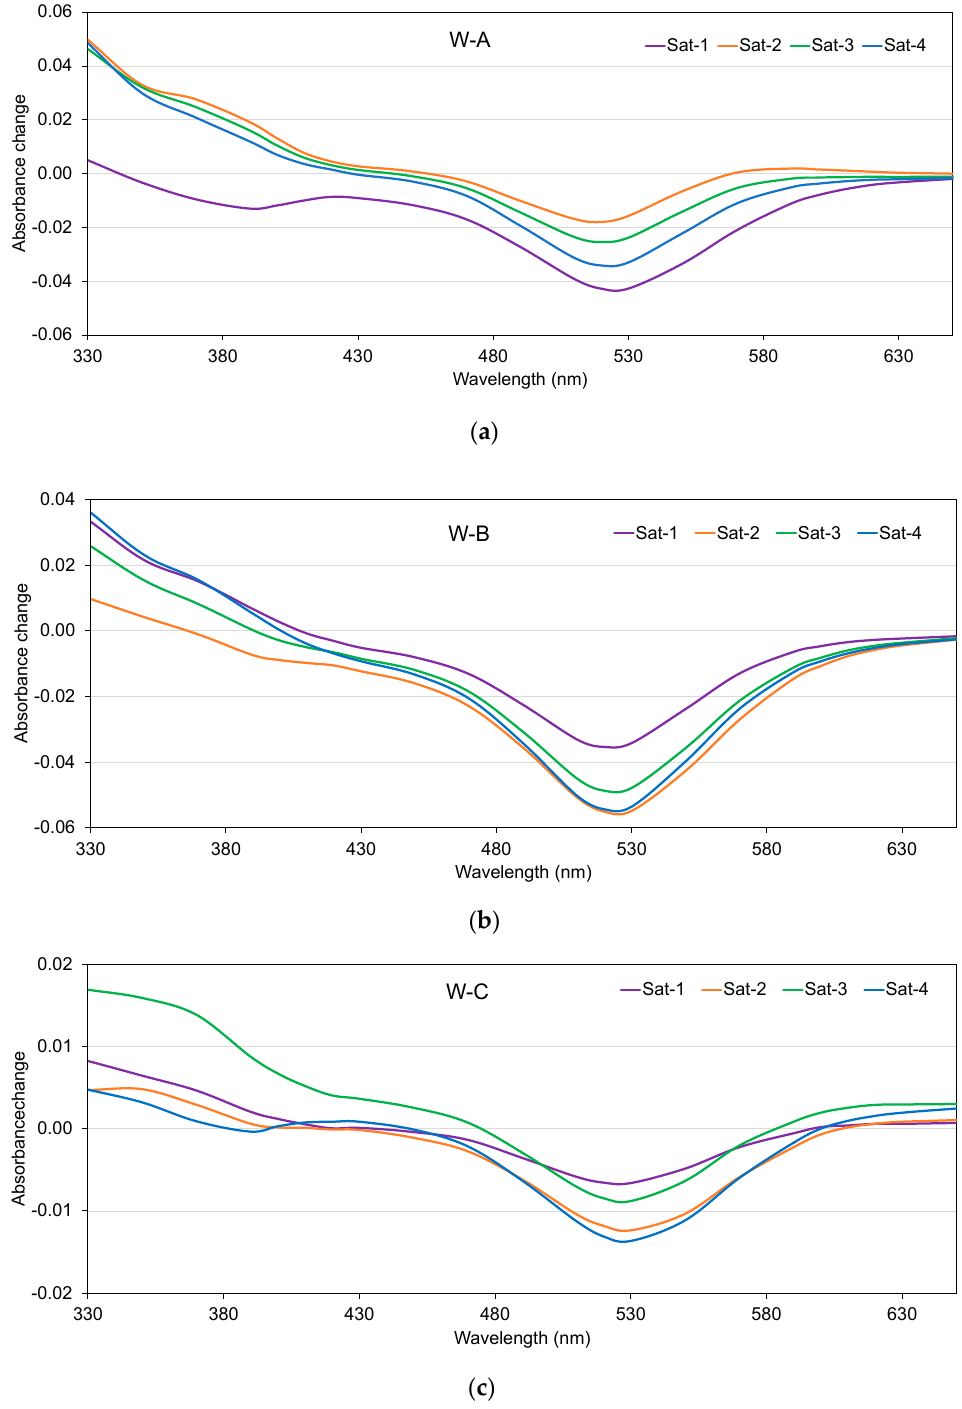
Figure 6. Changes in the spectrum of the Ws with different levels of oxygen (Sat-1: purple, Sat-2: orange, Sat-3: green and Sat-4: blue) with respect to the changes that occurred in Sat-0 (inert atmosphere). ( a ) W-A, ( b ) W-B, and ( c ) W-C.